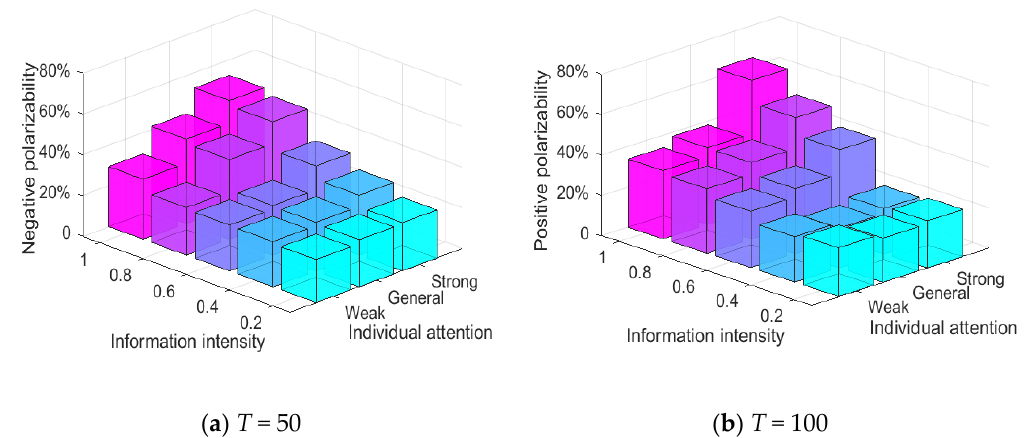
Figure 21. Relationship between information intensity, individual attention and attitude polarization. ( a ) T = 50; ( b ) T = 100.